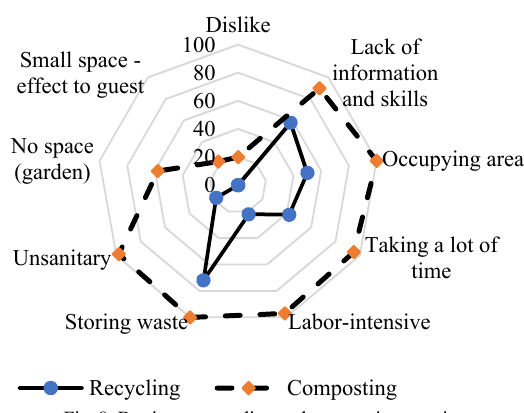
Fig. 8: Barriers to recycling and composting practices